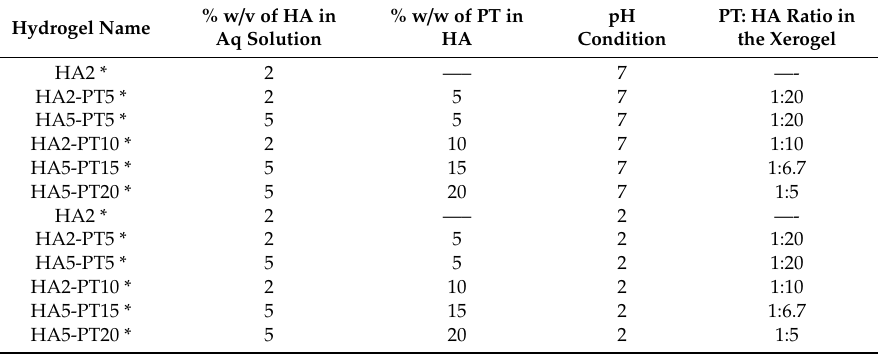
Table 1. Hydrogels formulated with HA and PT in neutral and acidic pH conditions.